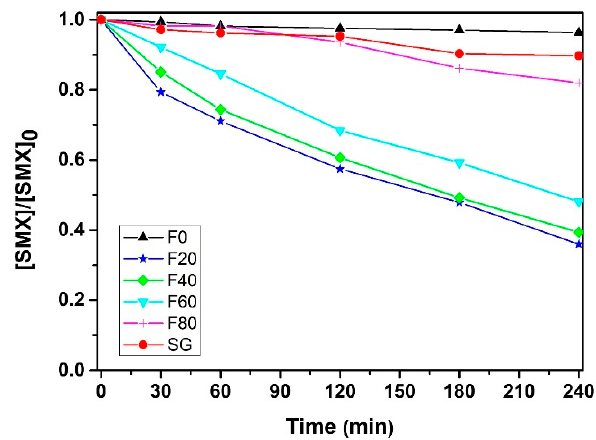
Figure 4. Degradation of SMX under UVA light.